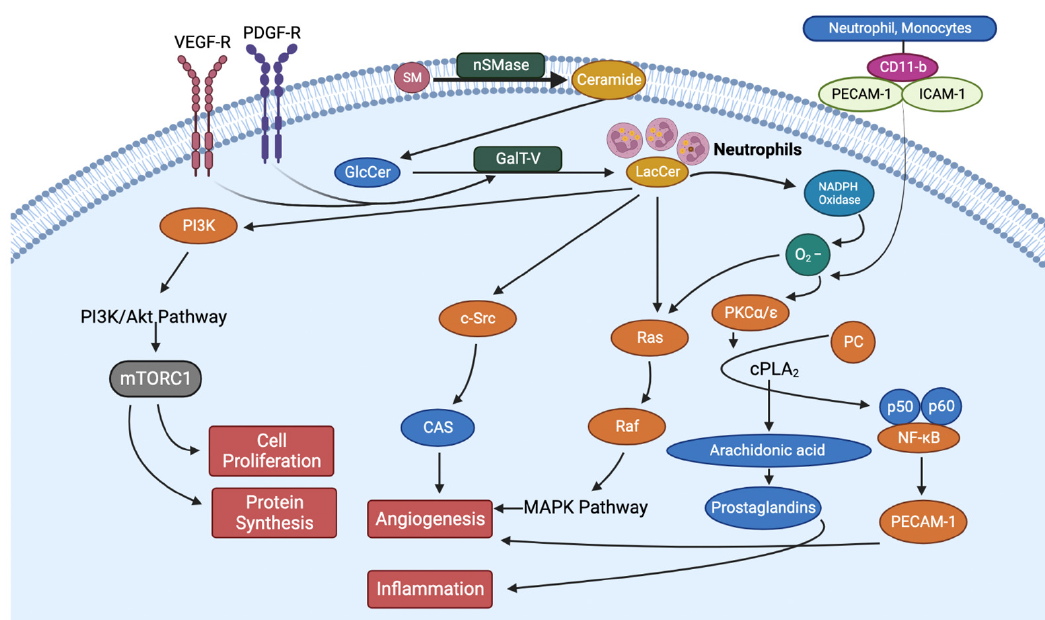
Figure 3. Signaling pathways by which LacCer affects diabetes and inflammation.